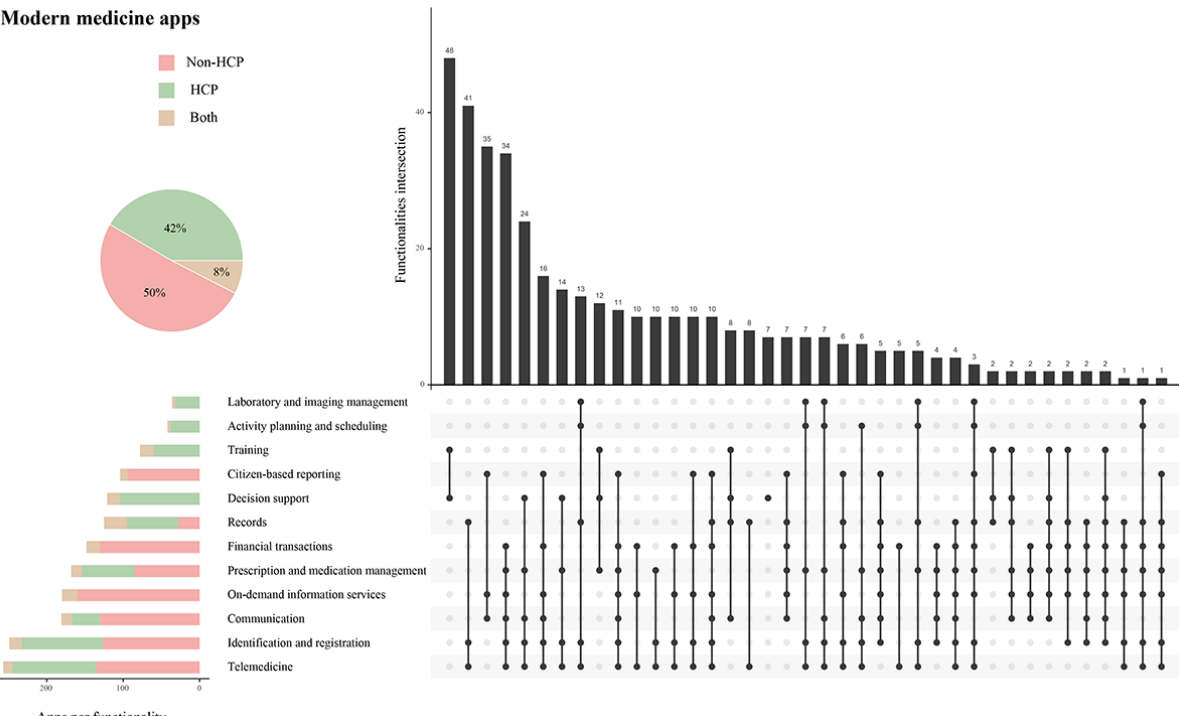
Figure 4. Modern medicine apps’ functionalities. Pie chart: portion of modern medicine apps’ target users. Stacked bar chart: distribution of modern medicine apps according to key functionalities and user type. Upset plot: intersection of multiple functionalities.